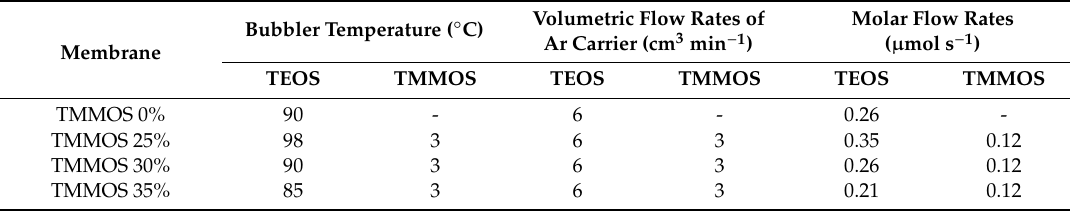
Table 1. Conditions of chemical vapor deposition for membrane